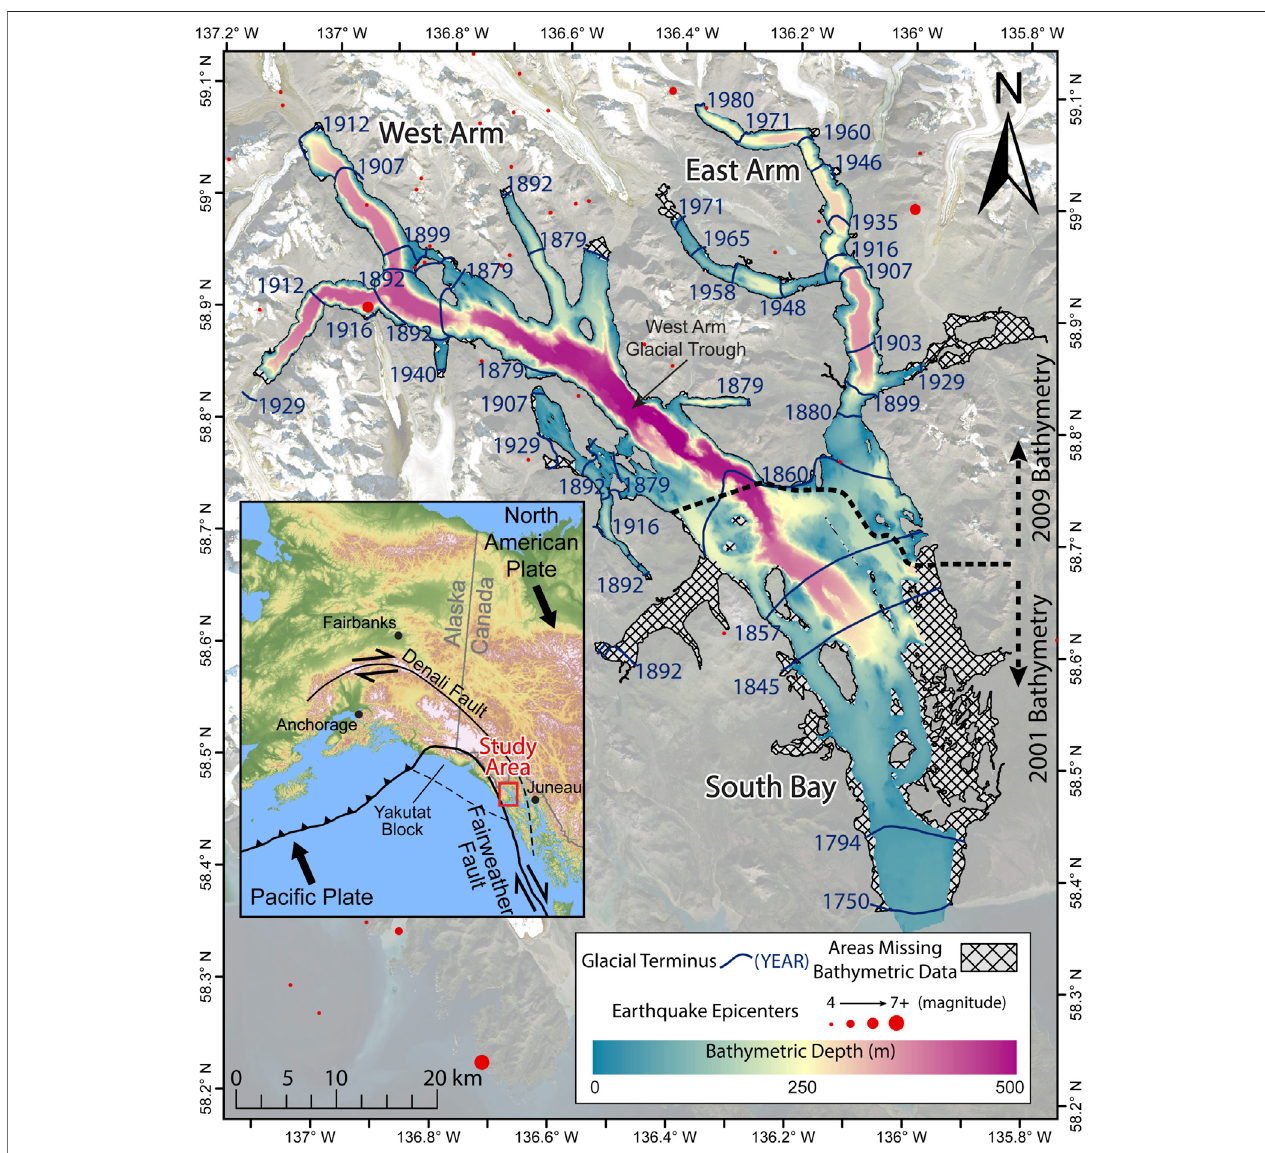
FIGURE 1 | Overview map of Glacier Bay and surrounding area. Bathymetry is sourced from two multi-beam sonar data collections in 2009 and 2001 for the northern and southern portions, respectively (NOAA and USGS). Earthquakes magnitude 4 and above are plotted at their epicenters for the period of 1899 – 2009 (compiled from https://earthquake.usgs.gov/earthquakes/search/). Glacial extent locations since the Little Ice Age are shown with their labeled years and are compiled from Powell (1980) and re fi ned using other original sources (see Materials and Methods ). For visual clarity, not all extents are shown on this map. Background imagery is from 2018 Landsat data. Inset map shows regional tectonic setting and geographic overview.